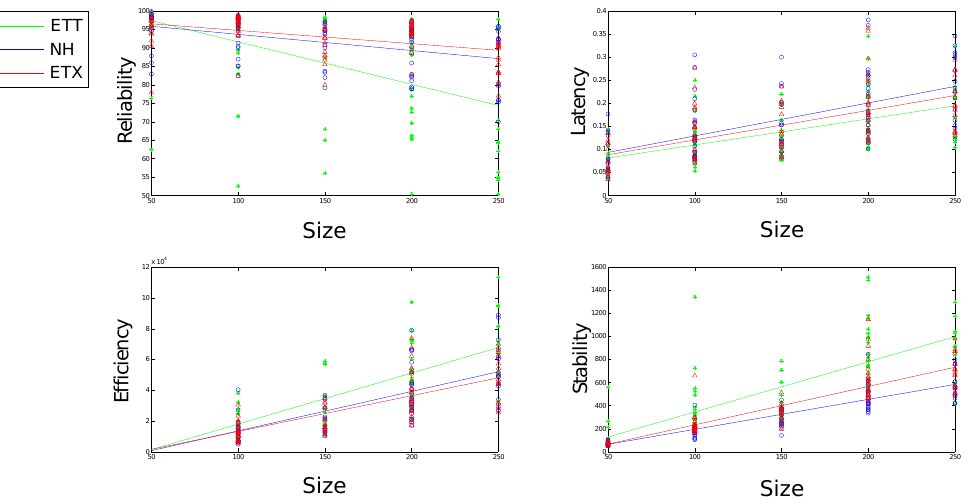
Figure 10. Network response from each solution as size varies.